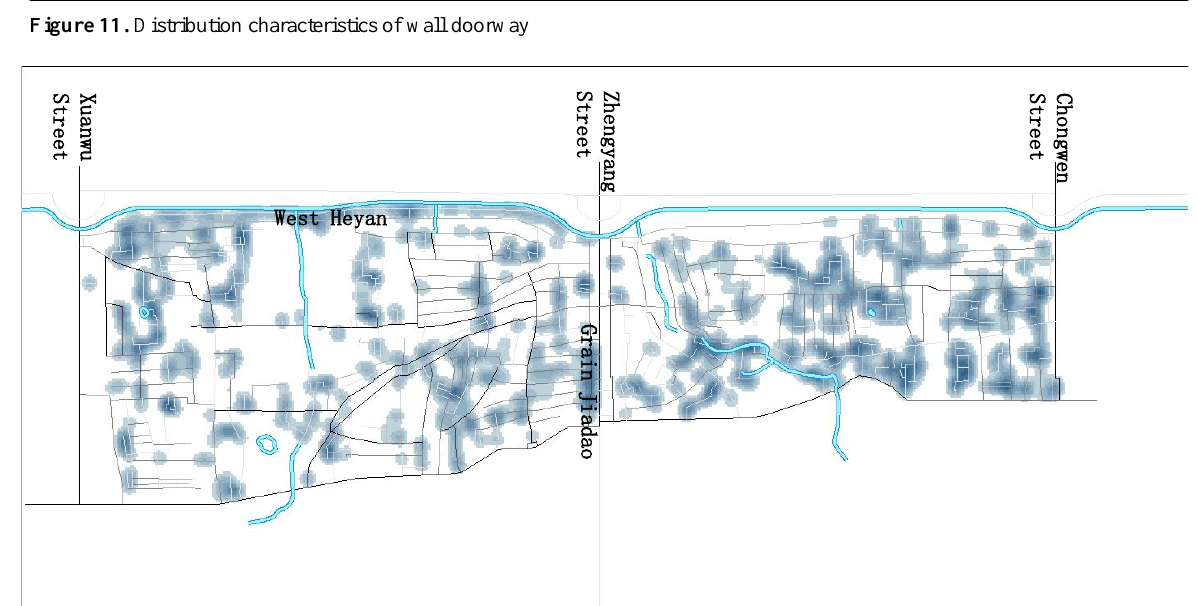
Figure 11. Distribution characteristics of wall doorway